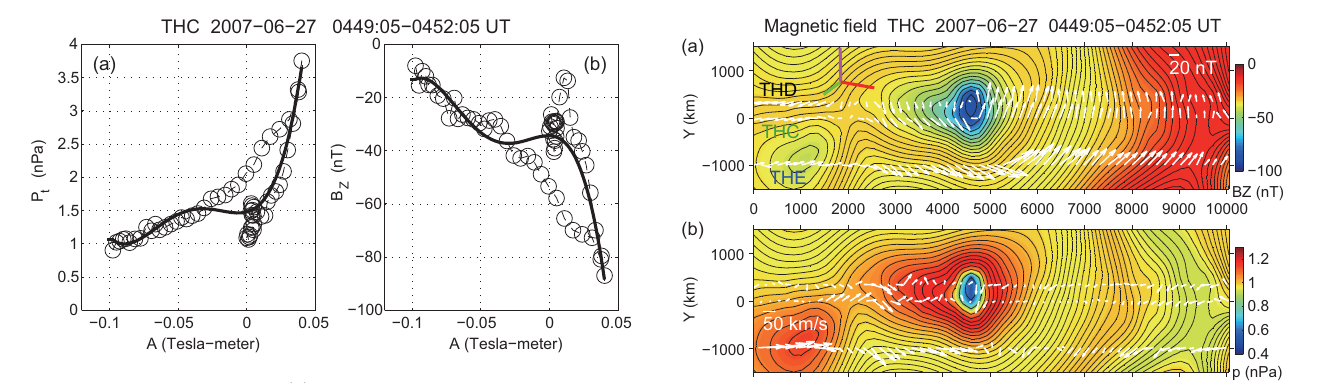
Figure 4. Scatter plots of (a) the transverse pressure, P t = p + B 2 /( 2 µ 0 ) , versus partial vector potential A and (b) of the ax- Z ial magnetic field component B Z versus A , for the invariant (Z) axis orientation estimated by maximising the correlation coefficient (Fig. 6b) between the field components measured and predicted, from the Grad–Shafranov reconstruction (GSR) using the THC data (Fig. 5), along the THE path. The circles show the measurements and the thick black curves are polynomial fits to the measurements.